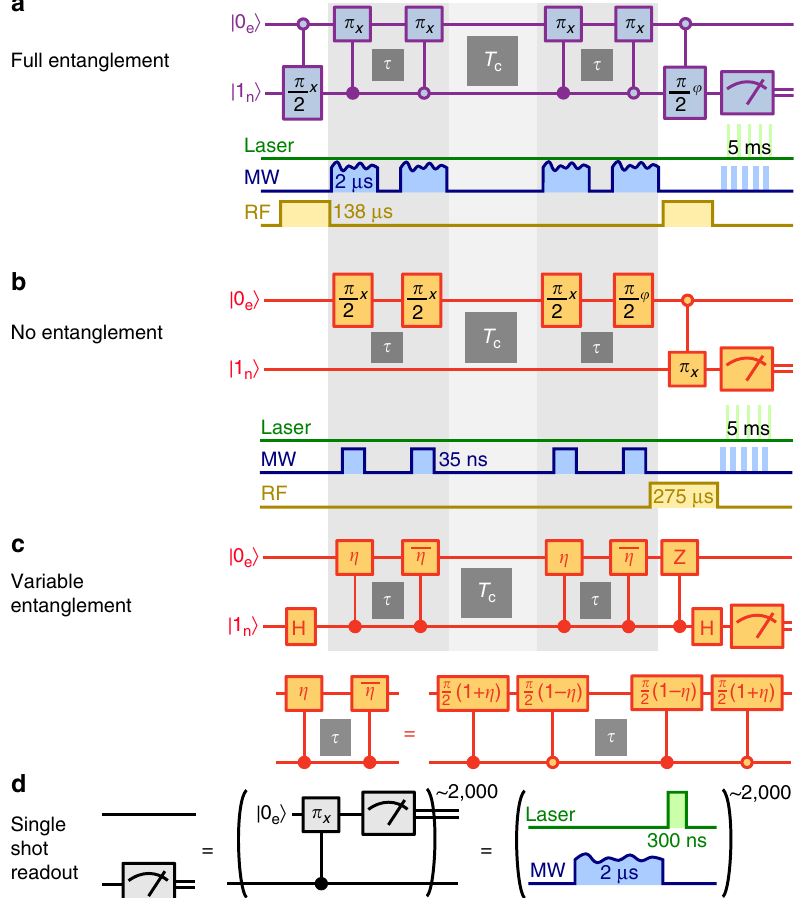
Figure 6 | Correlation measurements with and without entanglement. ( a – c ) Quantum wire diagrams for sensing with full quantum storage, classical storage and partial quantum storage, respectively. Qubit rotation operators R x , y , z ( y ) 16 are abbreviated as y x , y , z , for example, p x is a p rotation around the x -axis of the respective rotating frame. Open (filled) circles indicate operation of the respective gate on the target qubit conditional to control qubit states 0 j i 1 j ið Þ . Experimental realizations via free evolution periods and laser, MW and RF pulses are sketched accordingly. ( d ) Quantum wire diagram and schematized drawing for SSR. The MW pulse used for the realization of the C n ROT e -gate, here is illustrated by an amplitude modulated signal of duration 2 m s, which in our case is synthesized by the optimal control platform DYNAMO 26,41 . Fig. 7b. Apparently, over a spectral range of B 0.5MHz the quantum state of the memory spin shows almost full phase contrast and hence good fidelity. We introduce an effective sensing time t eff ¼ t 0 þ t , where t 0 accommodates for phase accumulation during C n ROT e -gate operations. The value of t 0 is estimated as follows. When the magnetic field stays constant during T c also these finite length pulses do not lead to total phase accumulation. Hence, we consider a nuclear spin with hyperfine coupling A zz ¼ 500kHz, which is flipped in T c . During the first two C n ROT e -gates it may be in state m exhibiting an initial shift of 250kHz. Thus it exhibits a shift of (cid:3) 250kHz during the second two C n ROT e -gates. According to our pulse analysis displayed in Fig. 7b this leads to a total phase accumulation of